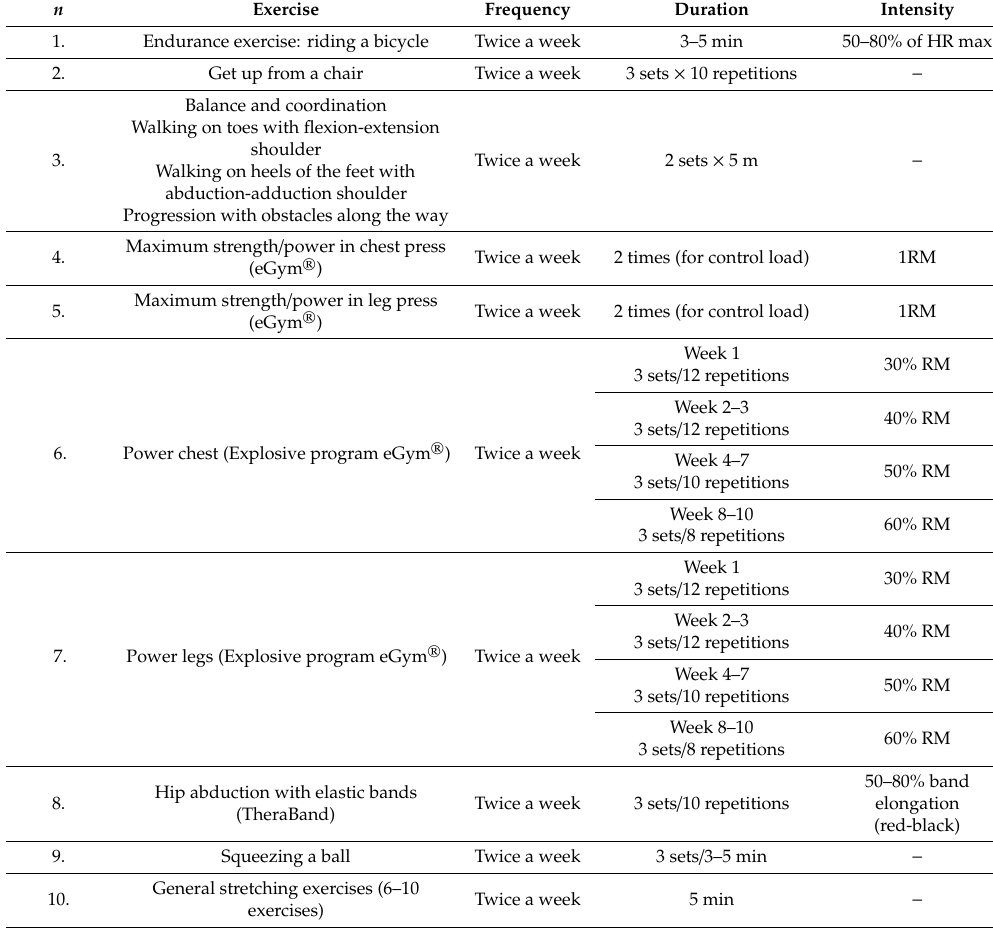
Table 1. Multi-component exercise